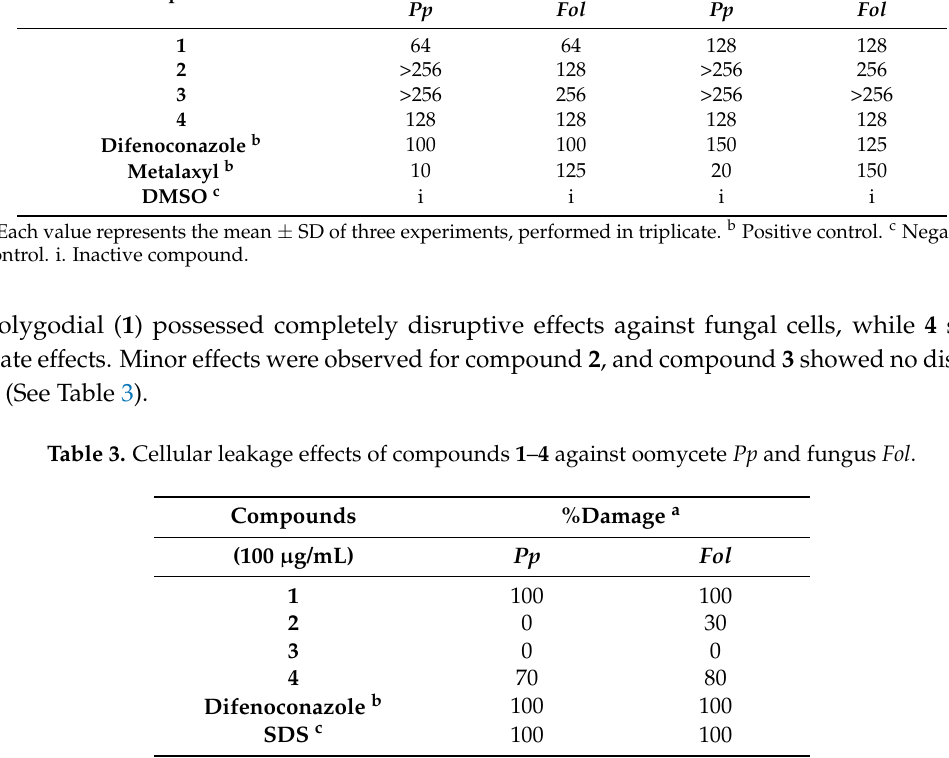
Table 2. The MIC and MFC values a of the compounds 1 – 4 against oomycete Pp and fungus Fol . MIC ( µ g/mL) MFC ( µ g/mL) Compounds